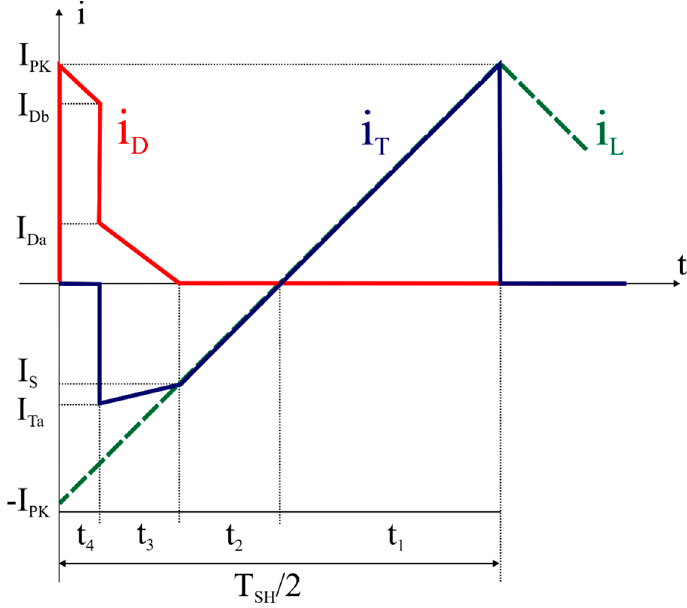
Figure 5. Square-wave-controlled half-bridge circuit: idealized waveforms of the transistor T H ( i T ) and diode D H ( i D ) current for the first half of the switching period T SH .